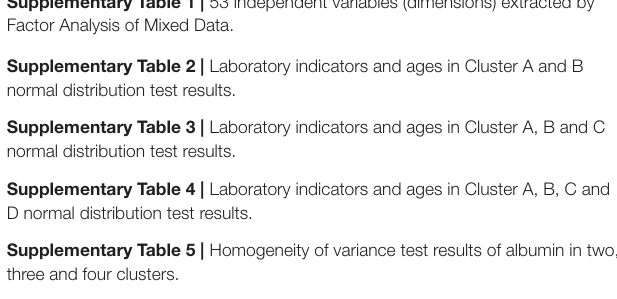
Supplementary Figure 5 | Parameter optimization of prediction model using the cross validated grid search. Overall dataset was randomly divided into 70% training and 30% tests datasets, and the optimal parameters were found by using grid search based on 10-fold cross-validation on 70% training dataset. (A) Kappa